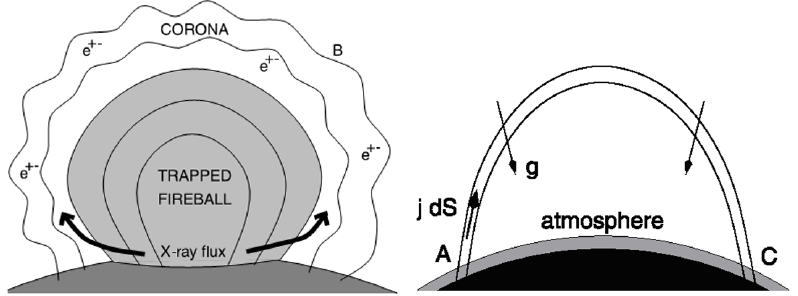
Fig. 2. Schematic views of a trapped (cid:12)reball (left) and a single current-carrying coro- nal loop frozen into the neutron star surface (right). The electric current is initiated by starquakes, which lead to twisting of one or two loop footpoints (A and/or C). The cur- rent (cid:13)ows along the loop, and it is closed in the metallic crust of a magnetar (Beloborodov & Thompson